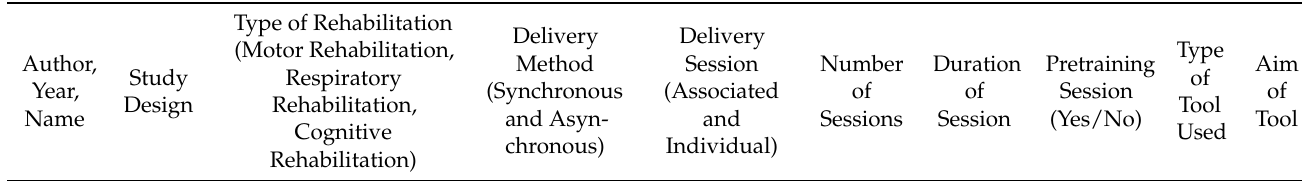
Table 2. Different telerehabilitation tools and their